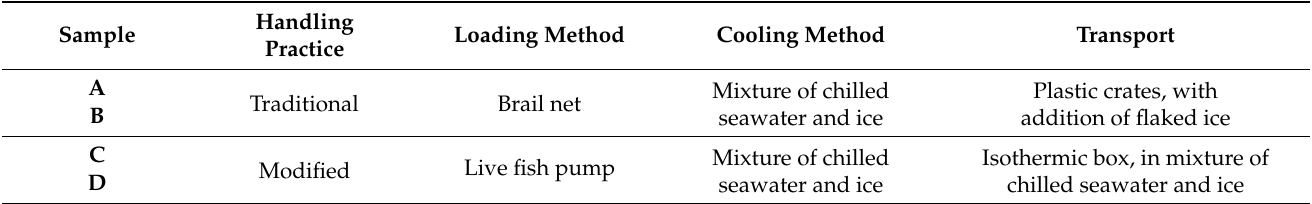
Table 1. Overview of handling practices and operations onboard vessels A, B, C, and